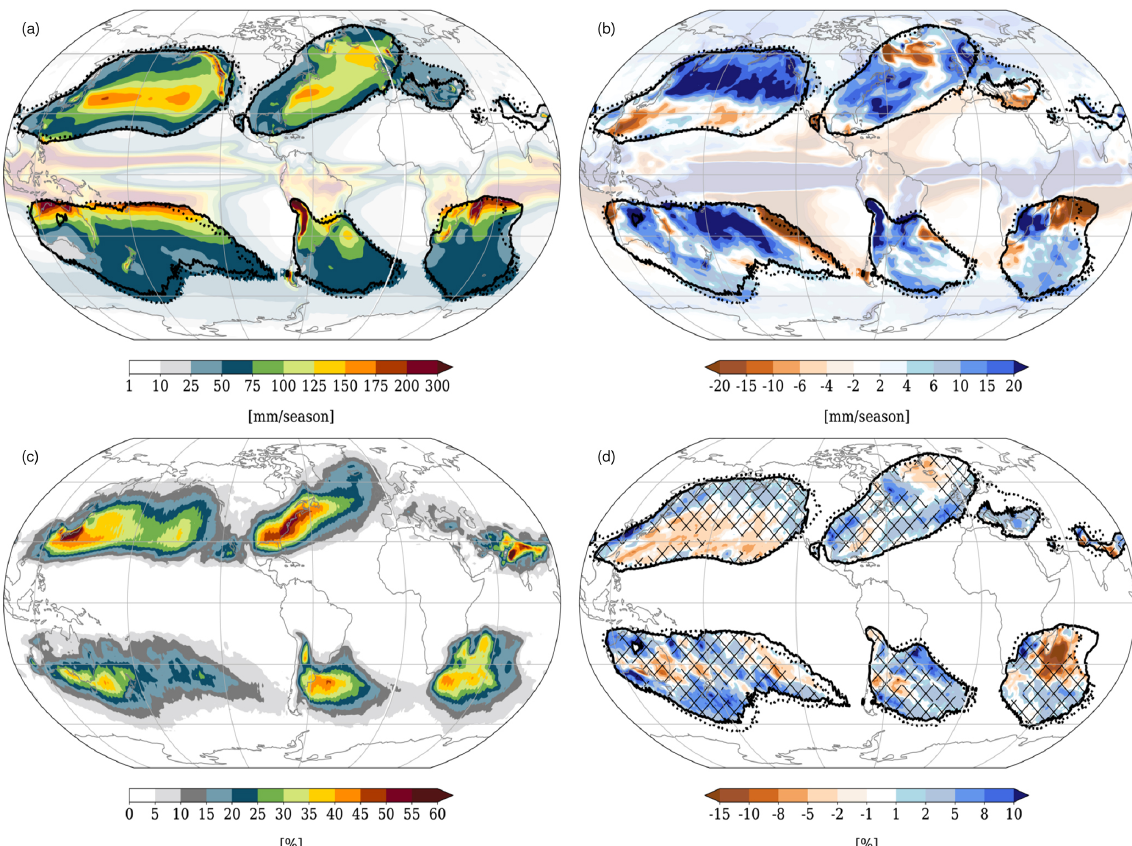
Figure 13. (a) The 50-year climatology of total precipitation in DJF (in mm per 3 months) for HIST, (b) difference in total precipitation between RCP8.5 and HIST, (c) percentage of precipitation that is linked to WCBs in DJF, and (d) difference of RCP8.5 minus HIST for percentage of DJF precipitation linked to WCBs. Solid and dashed black lines denote the 1% occurrence frequencies of WCB inflow and ascent (i.e. while the air parcels are located below 400hPa). Hatched regions show where there is an increase in total precipitation; thus they correspond to the blue colours in (b) . Fields are shown in pale colour (a, b) and not shown (c, d) in all regions where the occurrence frequencies of WCBs in the inflow and ascent phase are less than